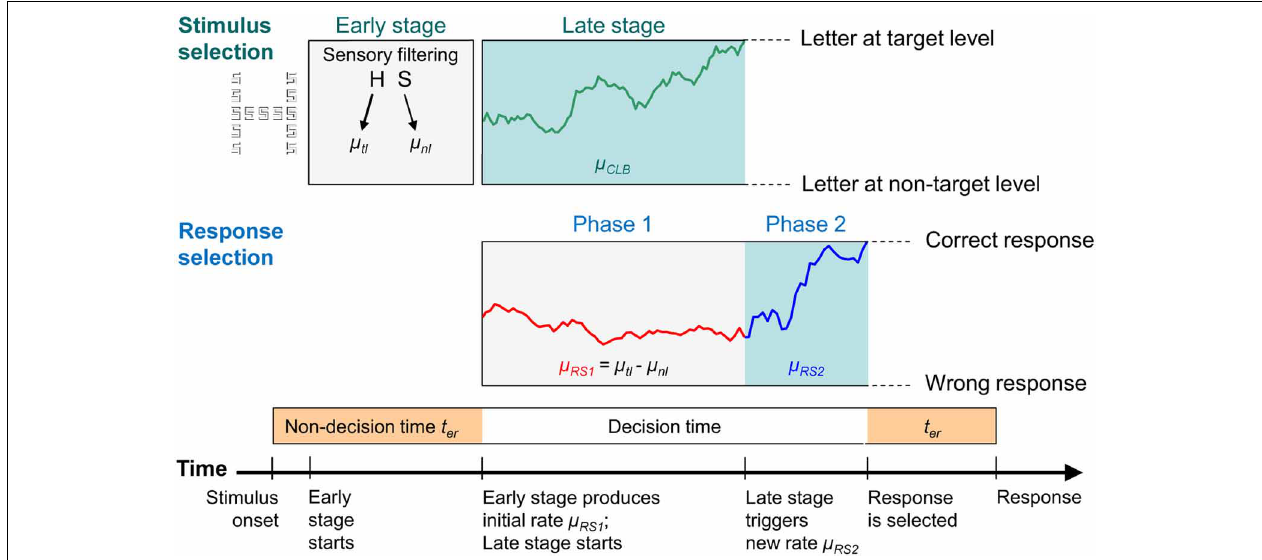
the two boundaries. Here, the upper boundary was hit, which leads to the binding of the target letter to the target level. After binding, response selection enters Phase 2, which is characterized by a new (higher) drift rate μ RS 2 . The decision is completed as soon as the response selection process hits one of the two response boundaries reflecting the choice alternatives. The duration for the non-decisional processes (sensory filtering, motor execution, etc.) is captured by the parameter t er